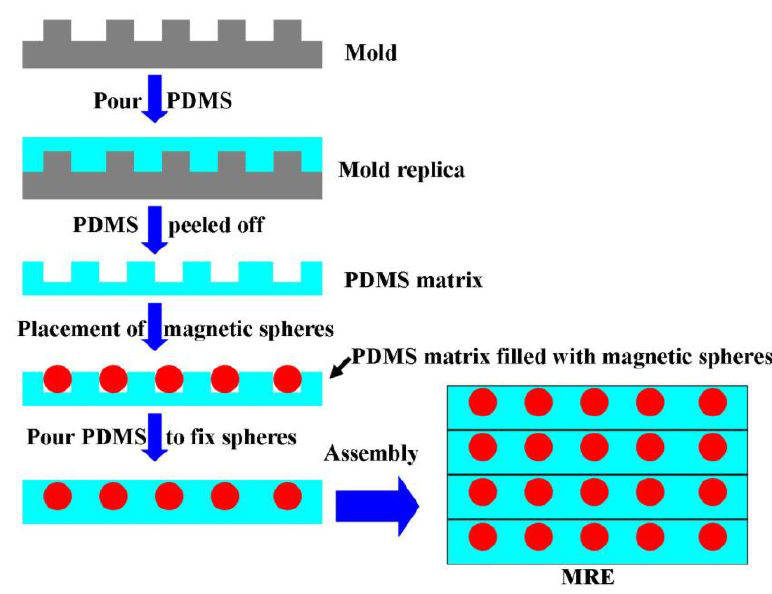
Figure 5. A typical fabrication process for